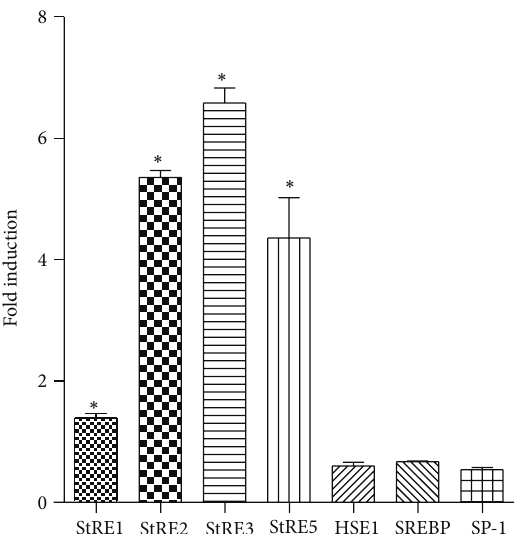
Figure 3: Effect of ZnPP on StRE1, StRE2, StRE3, StRE5, HSE, SREBP, and SP1 elements of human HO-1 promoter in PC-3 cells. PC-3 cells were transfected with enhancer-luciferase reporter plasmid harboring one of these elements, treated with 10 𝜇 M ZnPP for 48h, and luciferase activities were determined as described in Section 2. Results were expressed as “Fold Induction” over vehicle (DMSO)-treated control of the corresponding responsive element (mean ± S . E.). 𝑁 = 3 ; ∗ 𝑃 < 0.05 compared with vehicle-treated control of the corresponding responsive